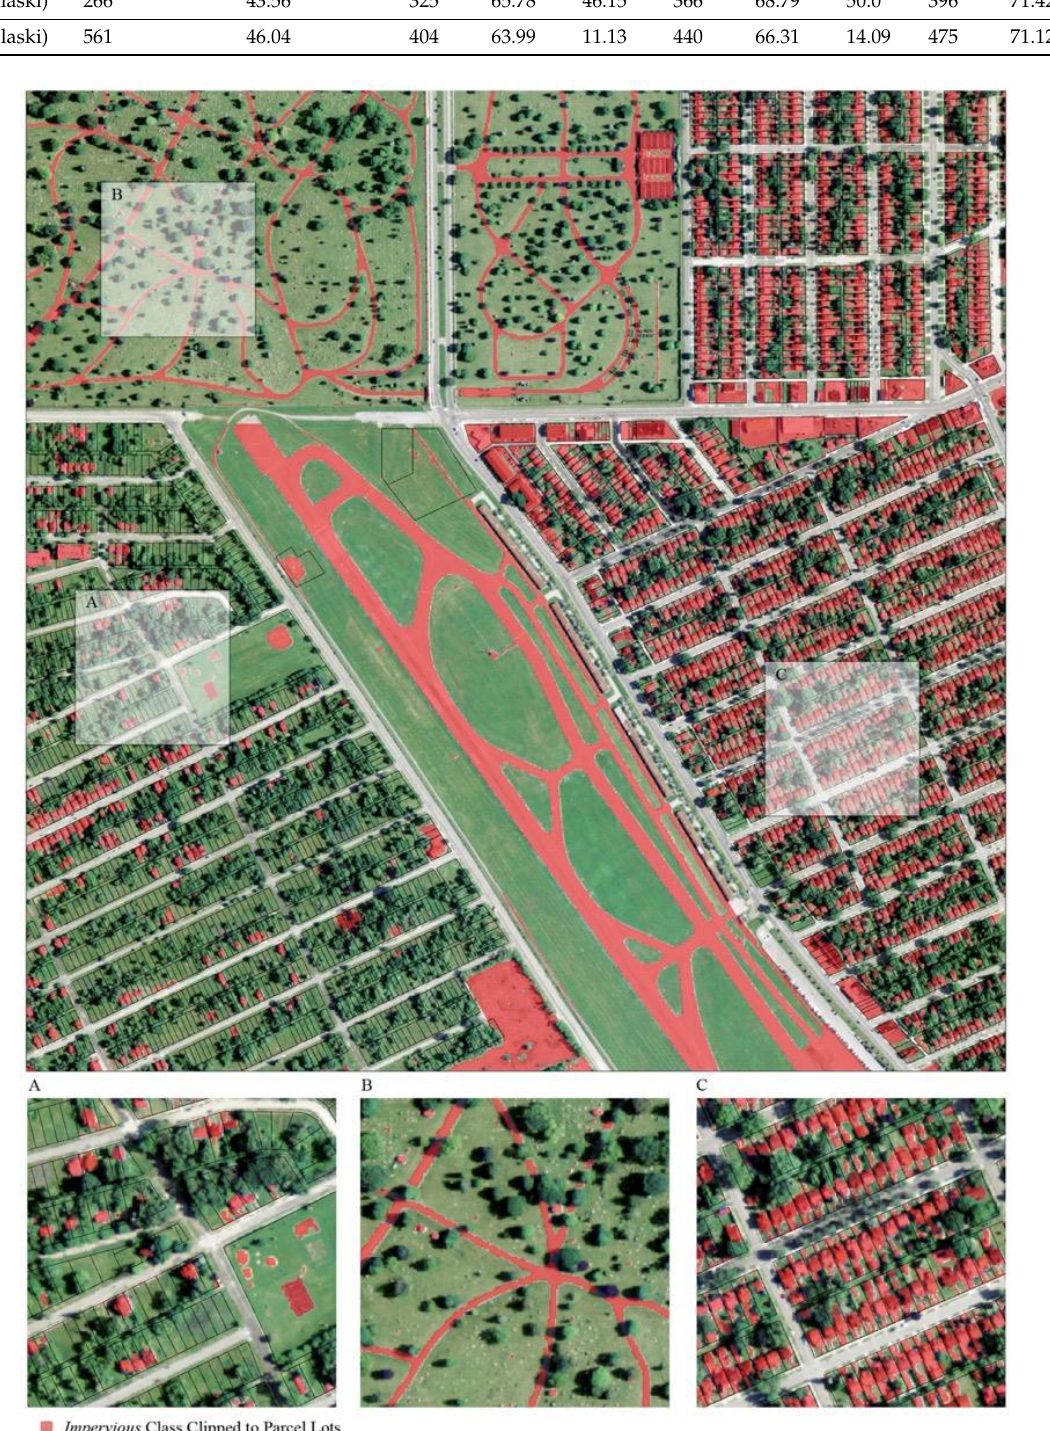
Figure 13. NAIP 2014 impervious surfaces on parcel lots. The shaded areas (A, B and C) in the upper portion of the figure are represented separately at higher resolution in the lower part of the figure.